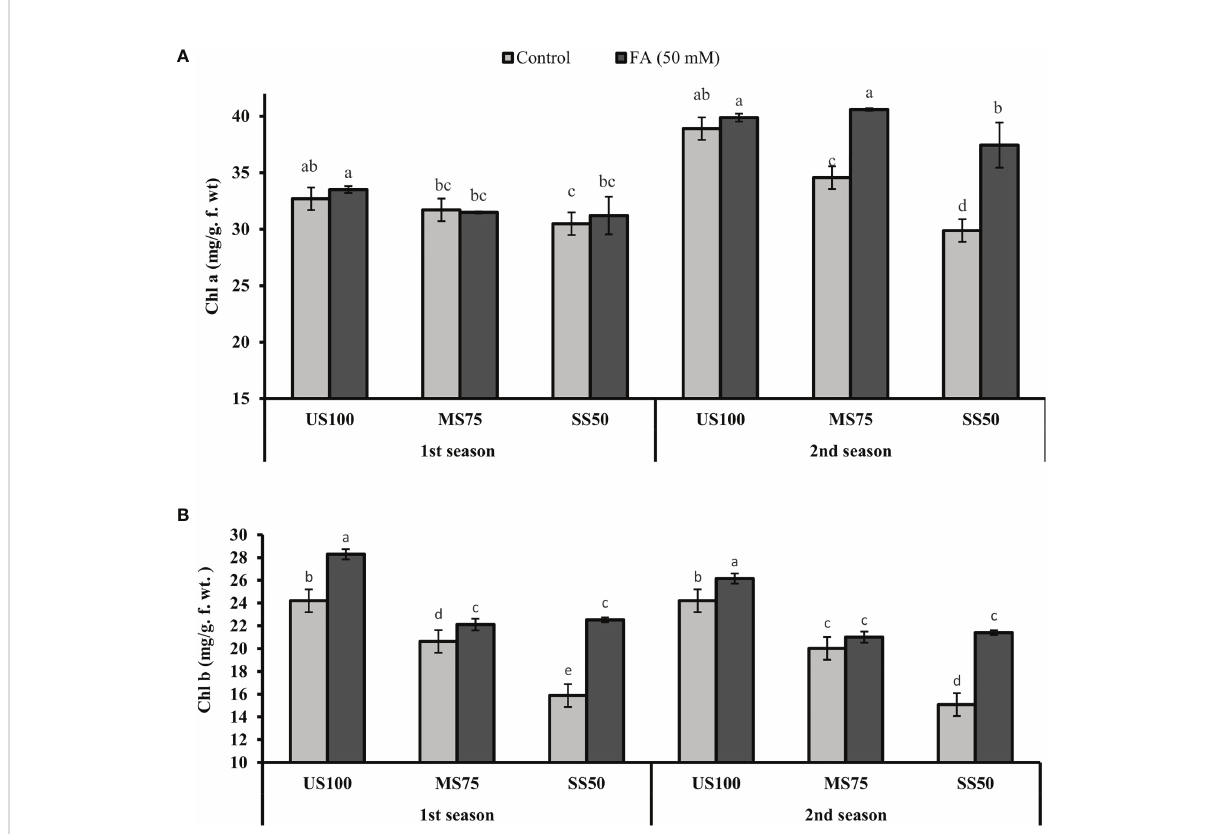
FIGURE 8 Effect of foliar application of folic acid (50 mM) on chlorophyll content (A) chlorophyll a and (B) chlorophyll b in the fi rst and second seasons. The graph values are the mean ± SE of four replicates. The bars exhibited with different letters indicate a signi fi cant difference between samples by least signi fi cant difference ( p ≤